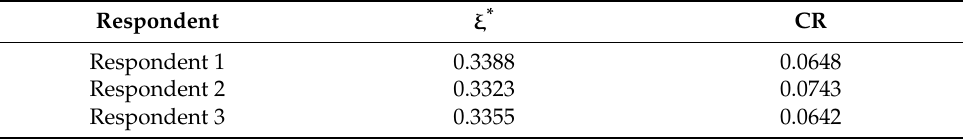
Table 10. Indicators to evaluate the outputs of the